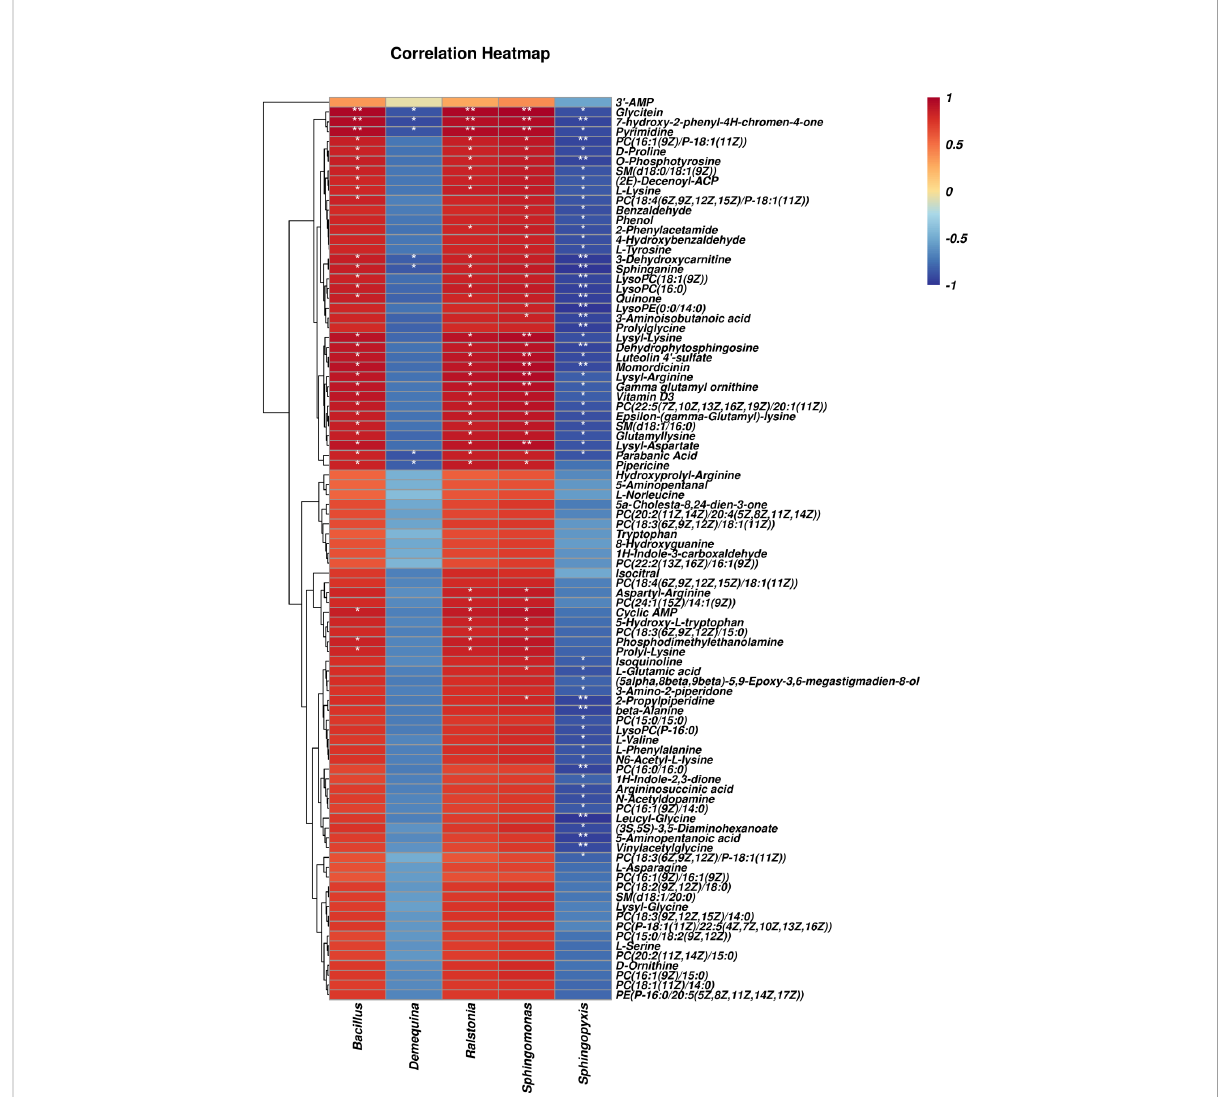
FIGURE 8 Correlation analysis of intestinal microbes and metabolites between LF and BC groups. Red represents a positive correlation; blue represents a negative – positive correlation. The darker the color, the stronger the correlation. * p < 0.05, ** p <